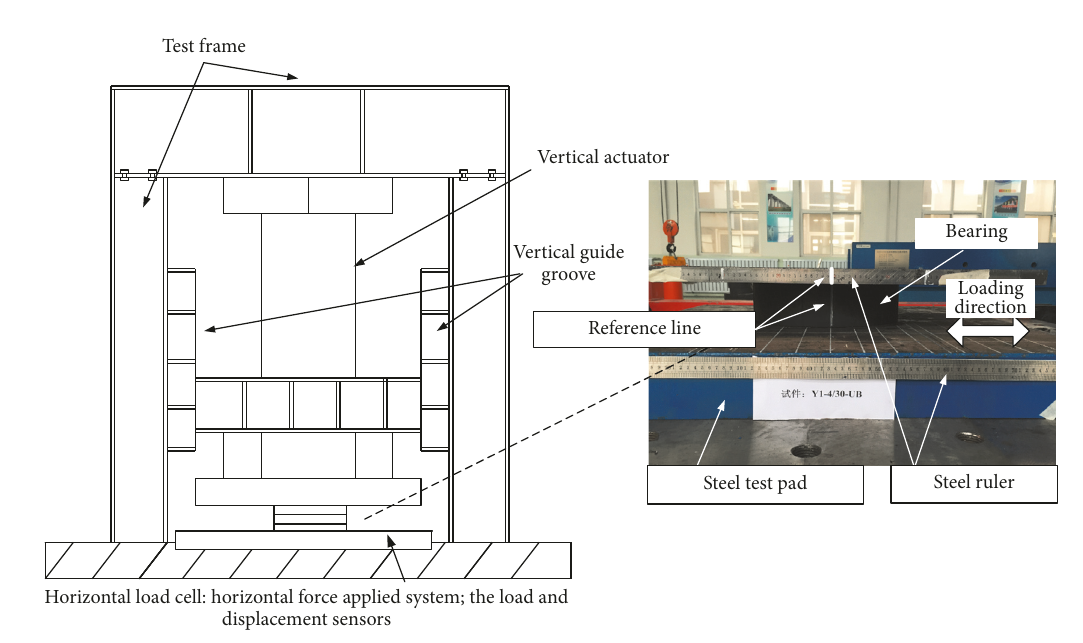
Figure 3: Testing